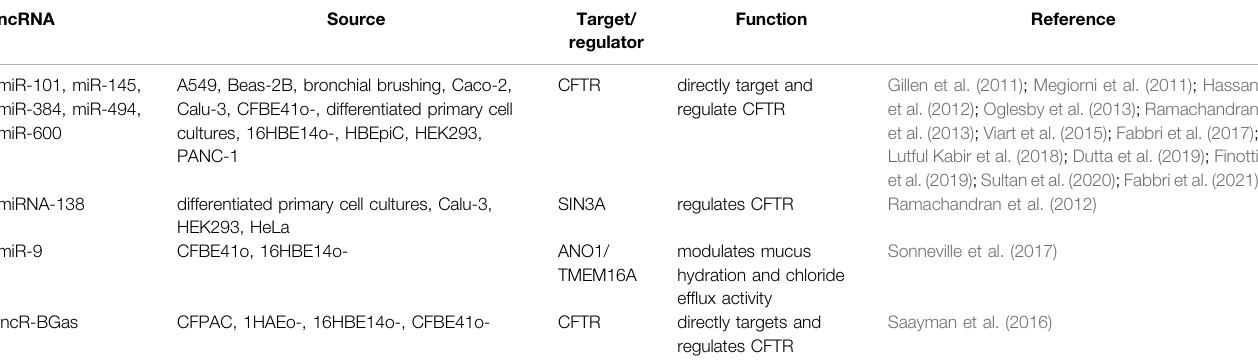
TABLE 3 | List of ncRNAs that directly or indirectly target and regulate CFTR in cystic fi brosis.